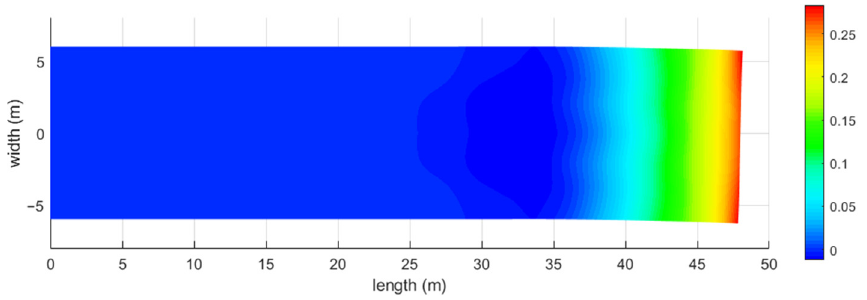
Figure 17. Vertical displacement field of the cantilever beam ( c = 1 Ns/m, t = 0.005 s,), under Heaviside step loading with an infinite